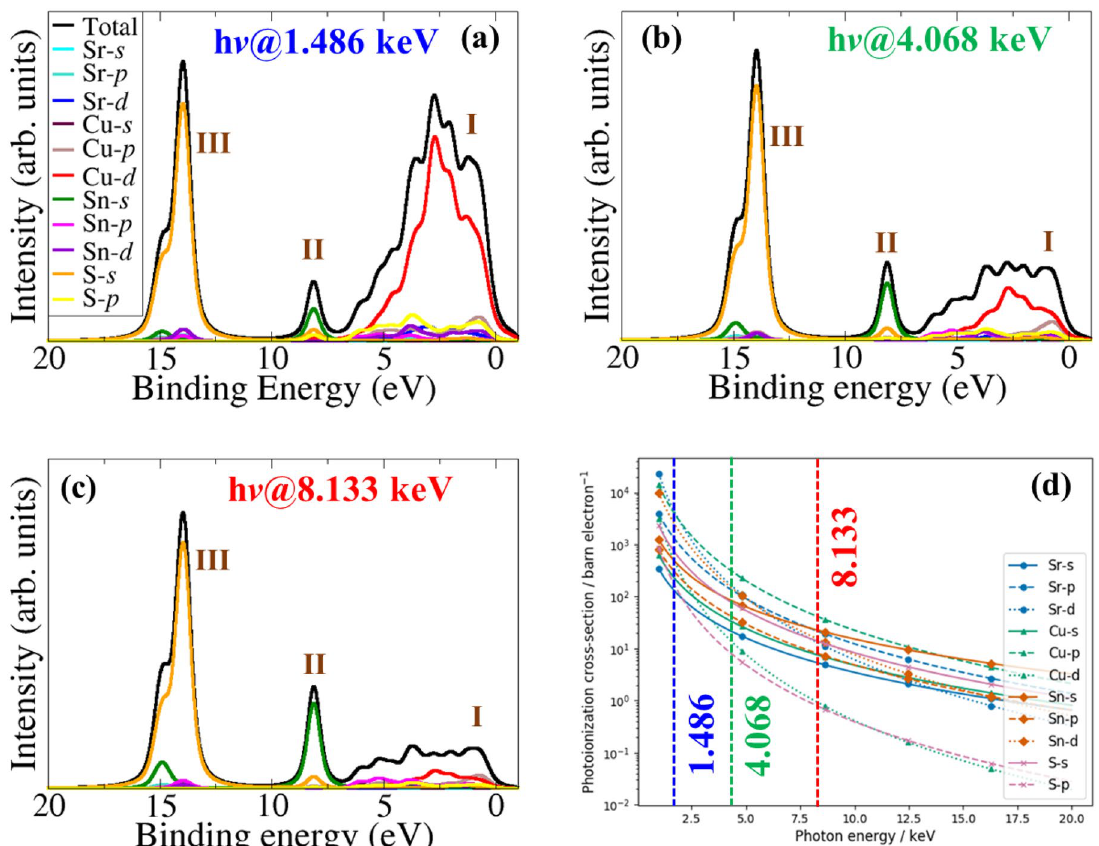
Figure 3. Simulated valence band edge spectra of Cu 2 SrSnS 4 at ( a ) Al Kα 1 (hν = 1.486 keV), ( b ) hν = 4.068 keV and ( c ) hν = 8.133 keV. The photoionization cross-section dependence on the ionizing photon energy for the valence orbitals in Cu 2 SrSnS 4 is shown in ( d